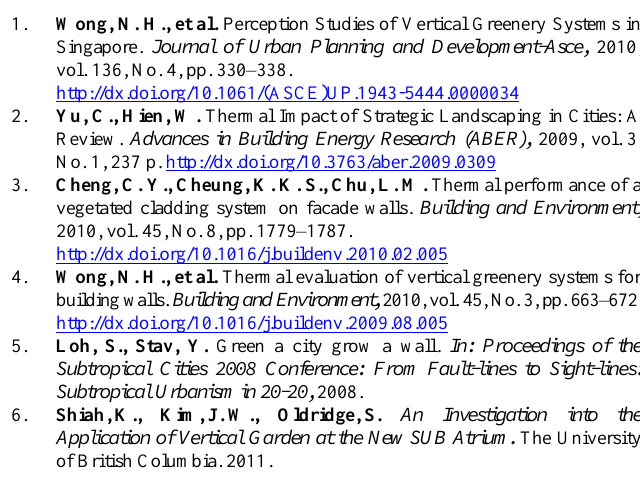
T EMPERATURE R EDUCTION P ROVIDED BY THE L IVING W ALL AND G REEN F ACADE Cavity Air